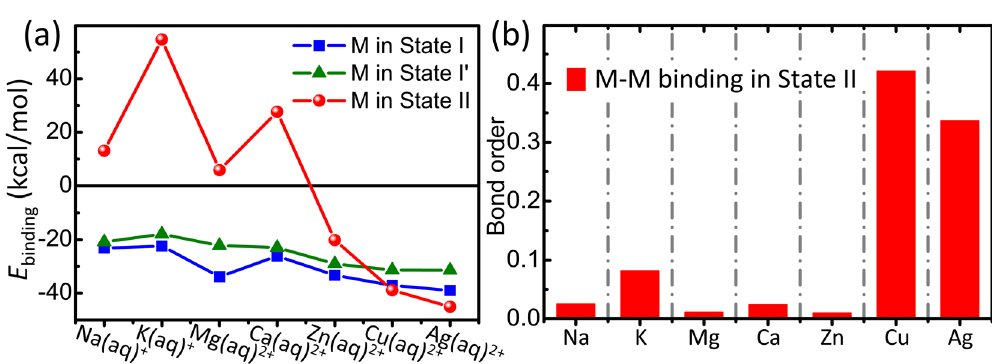
Figure 3. Binding energies ( a ) and bond orders ( b ) for hydrated metal ion M n + in States I, I ′ and II. n = 1 for M = Na and K, while n = 2 for M = Mg, Ca, Zn, Cu and Ag. The bond orders ( b ) suggest that a chemical bond with a covalent characteristic occurs for Cu and Ag and no bond occurs for the other metals. Moreover, the binding behavior of Cu 2 + in State II significantly differs from that of Zn 2 + , although Zn is the element just next to Cu in the periodic